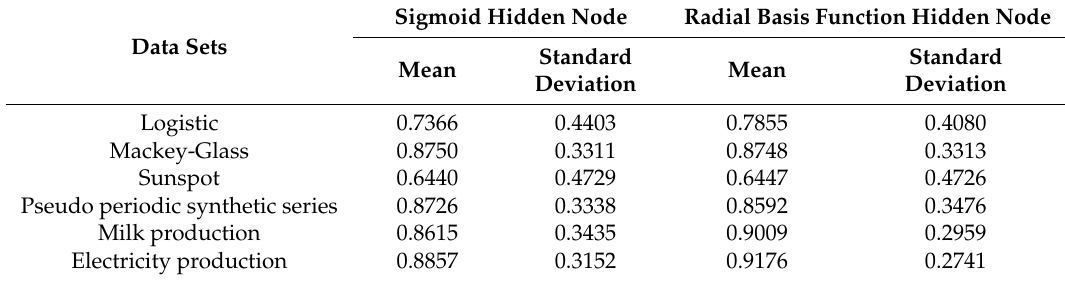
Table 2. Mean and standard deviation of the adaptive weights for AWOS-ELM